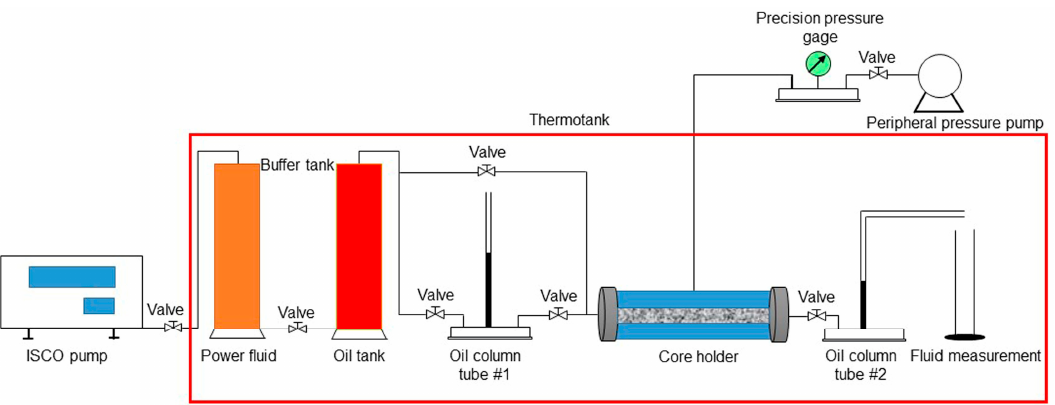
Figure 2. The schematic of the TPG measurement experiment.